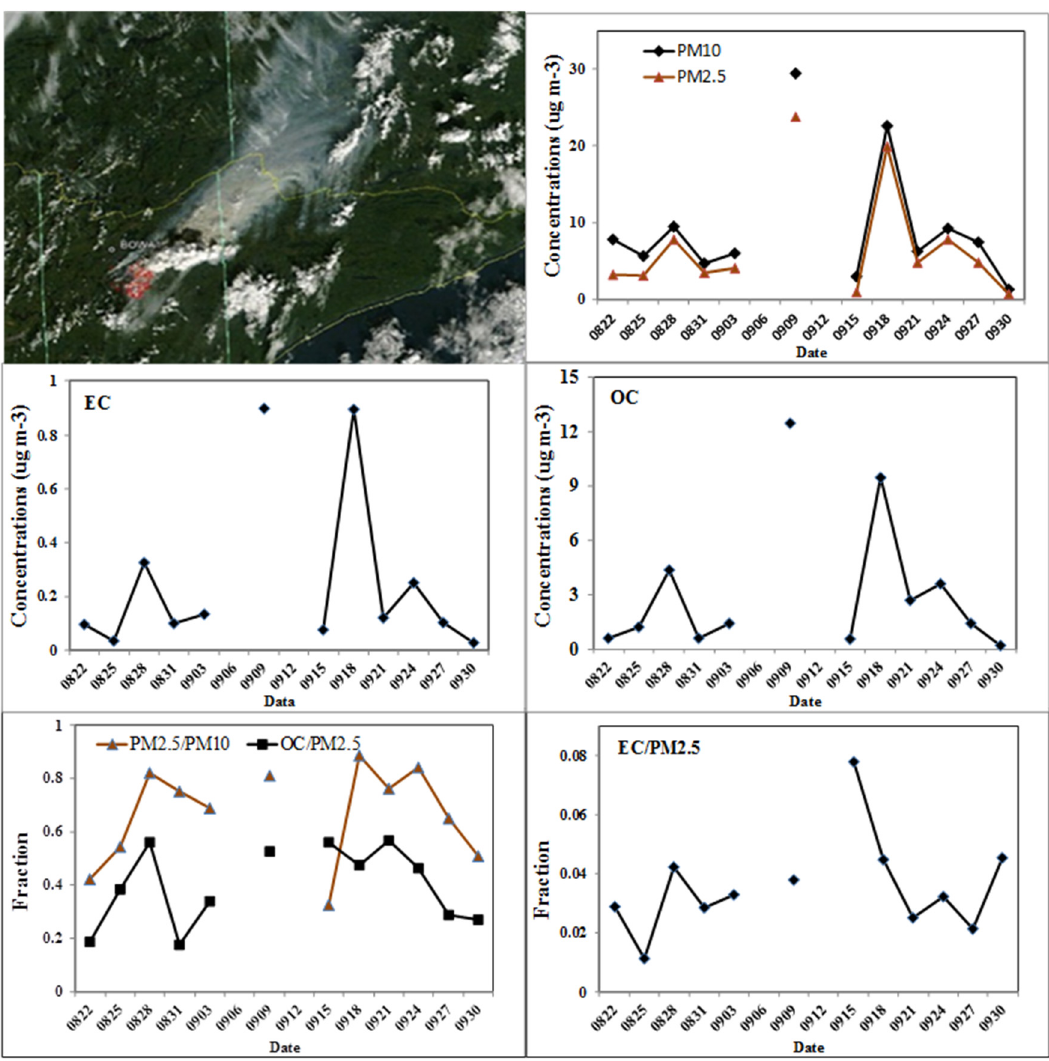
Figure 2. A case study of a fire event in September 2011 at the BOWA1 site. The MODIS on NASA’s Terra satellite captured the top left image on 12th September 2011. Red outlines show areas of high surface temperatures associated with active burning, near the BOWA1 site. Characteristics of fire-dominated aerosol (PM 2.5 , PM 10 , OC, and EC concentrations, ratios of EC, OC in PM 2.5 ) during the fire event episode are shown in other figures.